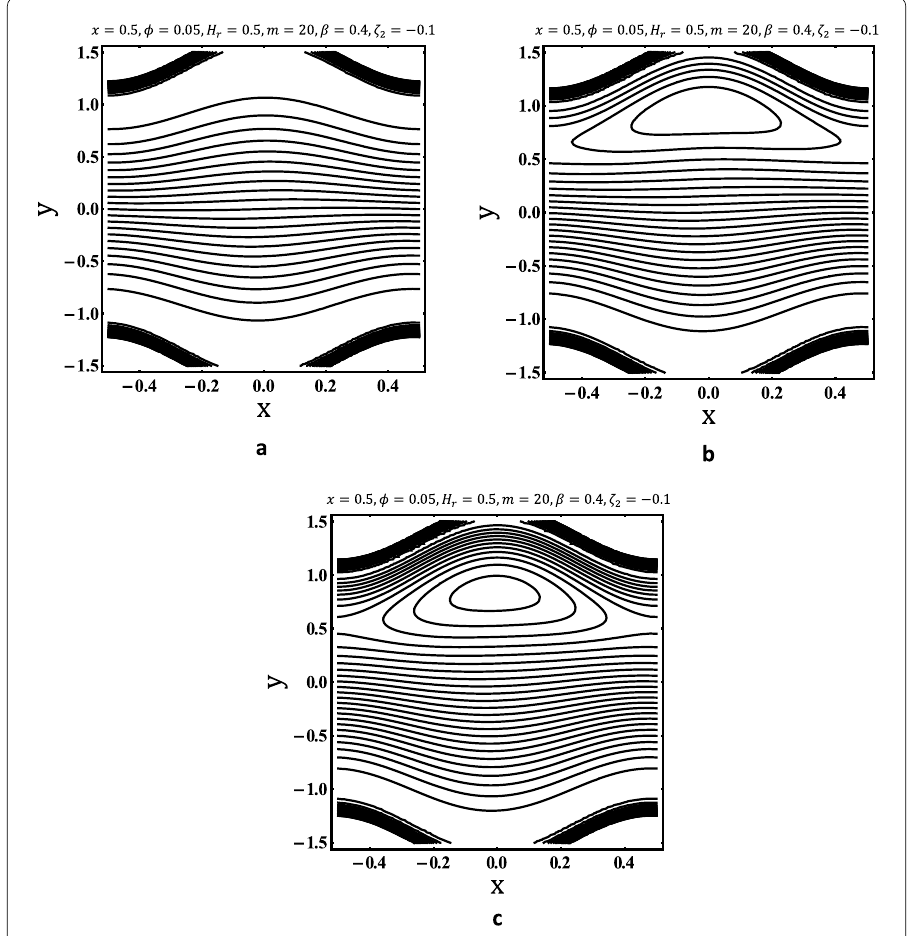
Figure 7 Streamline distribution for: ( a ) ζ 1 = –0.1, ( b ) ζ 1 = –0.5, and ( c ) ζ 1 = –1.0.